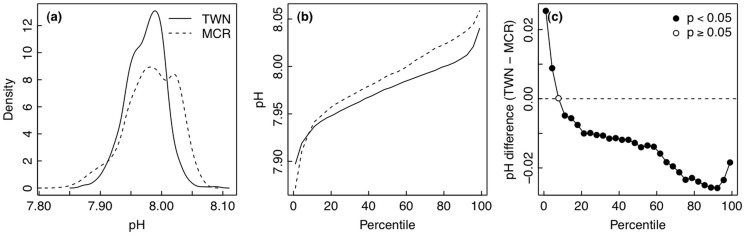
Comparisons of seawater pH between Moorea [MCR] and Taiwan [TWN].(a) Histogram of the frequency densities of pH values observed during the deployments. (b) Distributions of frequencies of pH values during the deployments. (c) Differences in pH (TWN—MCR) for each percentile of the distribution of seawater pH, tested whether different from zero using Monte Carlo randomizations.